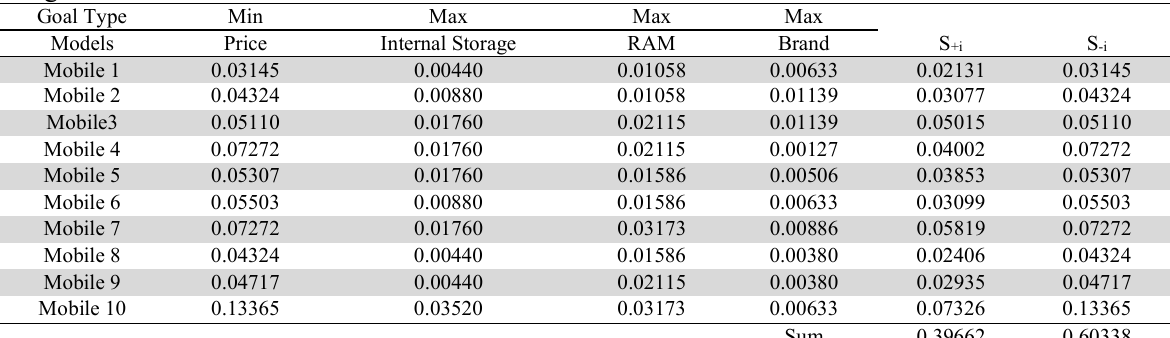
Weighted Normalized Matrix Goal Type